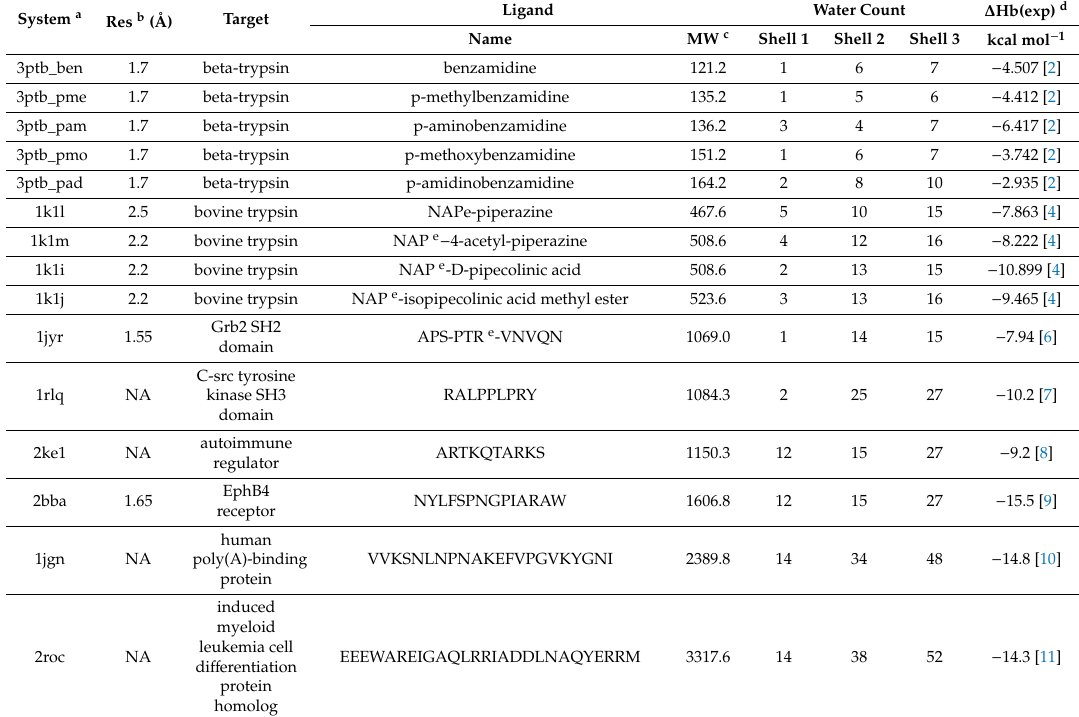
Table 1. Target-ligand